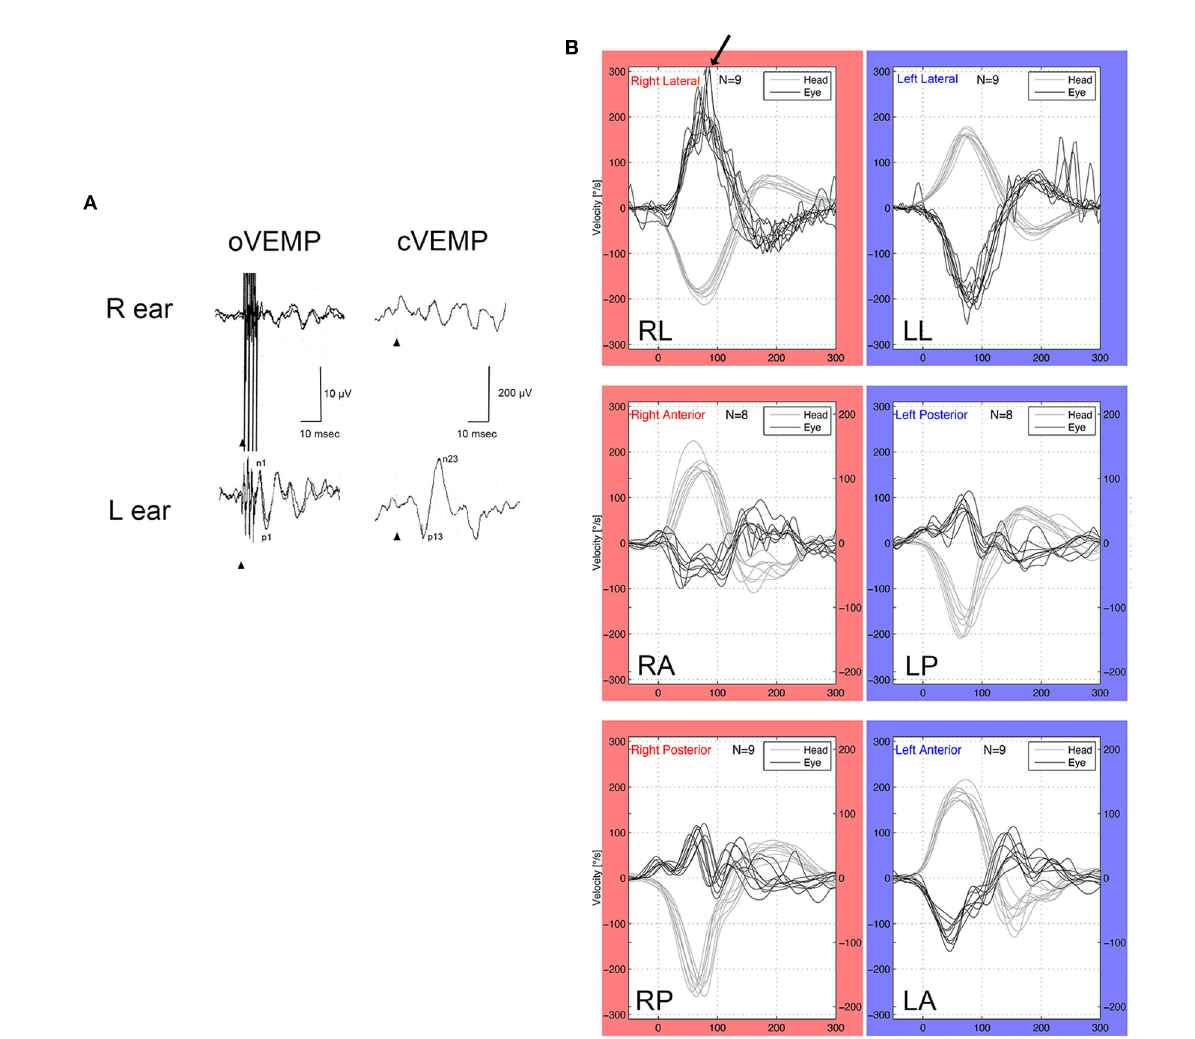
FIGURE3 VEMP and vHIT. (A) oVEMP (500-Hz bone conduction) and cVEMP (500-Hz air condition). The patient had normal oVEMP and cVEMP on the unaffected side (left ear), and she presented with abnormal oVEMP and cVEMP in the affected side (right ear). (B) vHIT showed hyporeflexia in the anterior and posterior semicircular canals of both ears. Meanwhile, vHIT of the left lateral semicircular canal was normal, and vHIT of the right lateral semicircular canal had covert saccades (arrow), which indicated that the right lateral semicircular canal had decreased